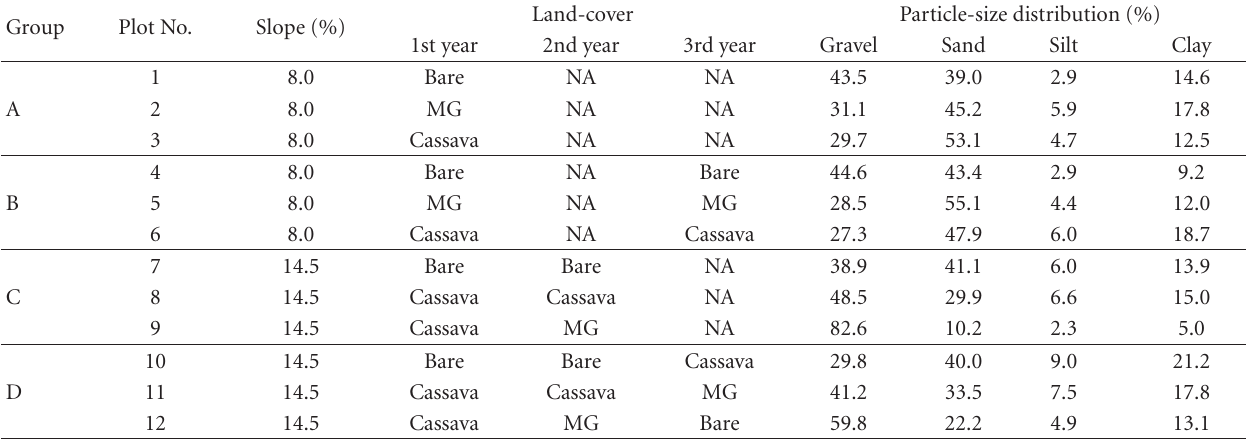
Table 1: Slope, land-cover, and particle-size distribution of topsoil in the twelve plots. Land-cover Particle-size distribution (%) Group Plot No. Slope (%) Gravel Sand